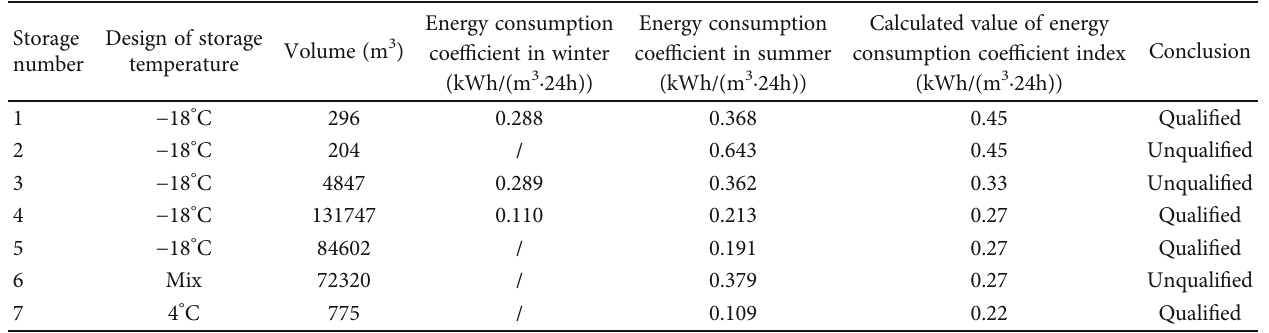
Table 8: Statistical table of energy consumption coe ffi cient for di ff erent seasons and cold storages.